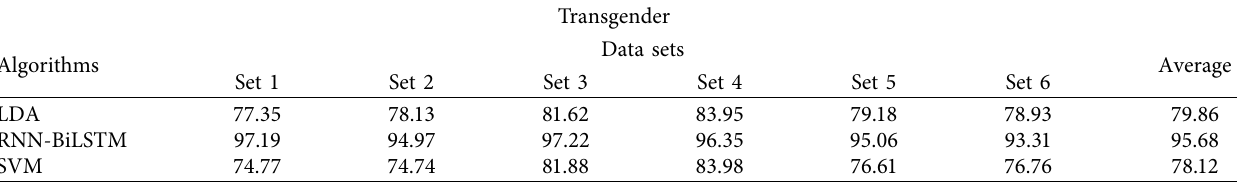
Table 4: Average and recall values for proposed models to identify the transgender voice